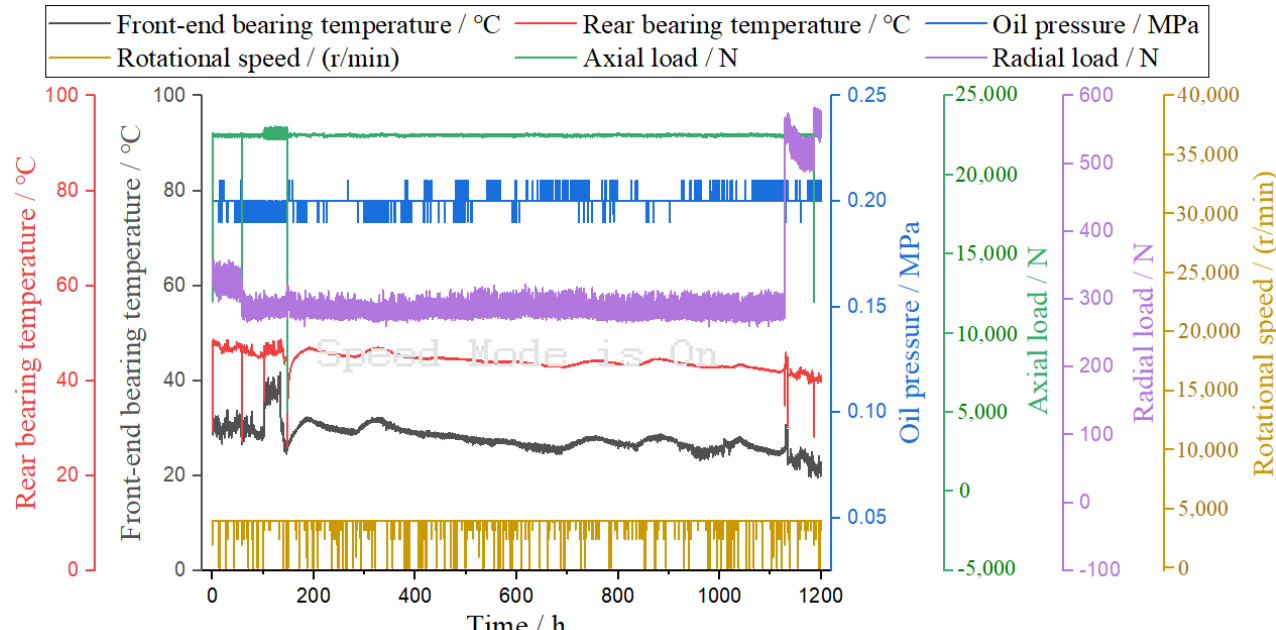
Figure 5. Heavy-load durability testing of high-performance bearings.